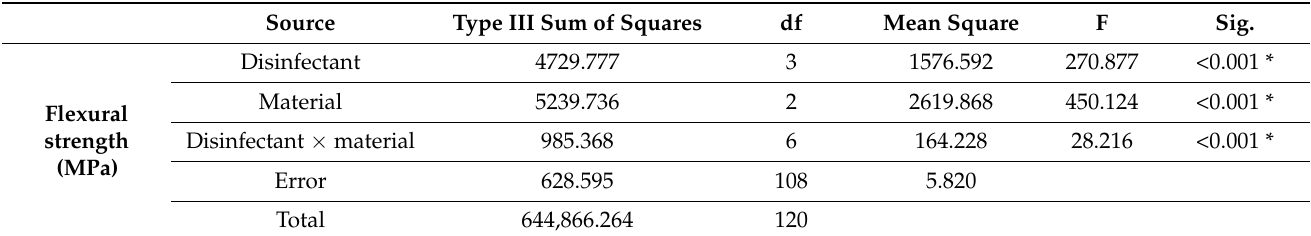
Table 4. Two-way ANOVA results of the tested